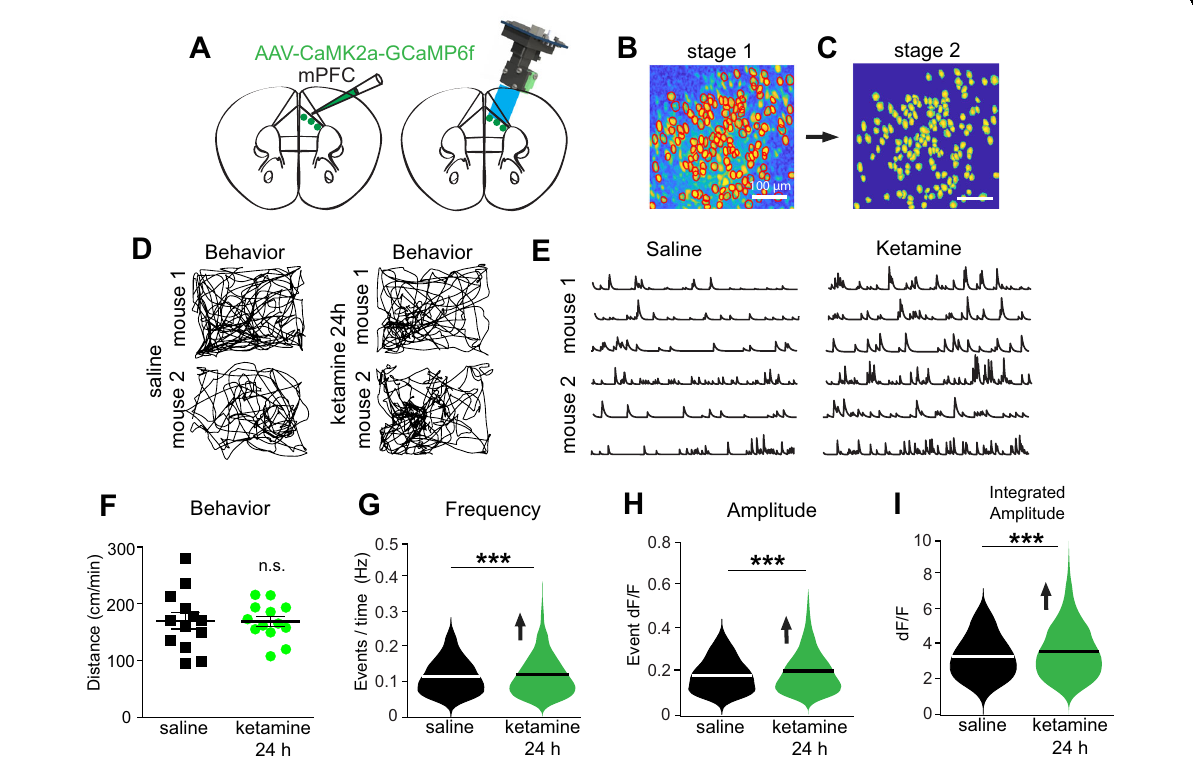
Fig. 2 Subanesthetic ketamine increases mPFC excitatory neuron activities in vivo. A (Left) A schematic illustration of AAV injection for targeted expression of GCaMP6f in mPFC excitatory neurons. (Right) A schematic illustration of a miniaturized fl uorescent microscope (miniscope) used to image in vivo calcium signals in mPFC excitatory neurons in awake and freely behaving mice. The GRIN lens, implanted over mPFC at 2 weeks after an AAV-CaMK2a-GCaMP6f injection into mPFC, is shown in blue. B , C Representative neuron footprints to be used for data analysis after stage 1 (CNMF-E)(B) and stage 2 (SCOUT) processing of the same data. D Behavioral tracking data (black lines) of two representative mice. The mice were introduced to a 35 cm × 25 cm behavioral arena under low-lighting conditions (<20 lux), and miniscope and behavioral recordings were